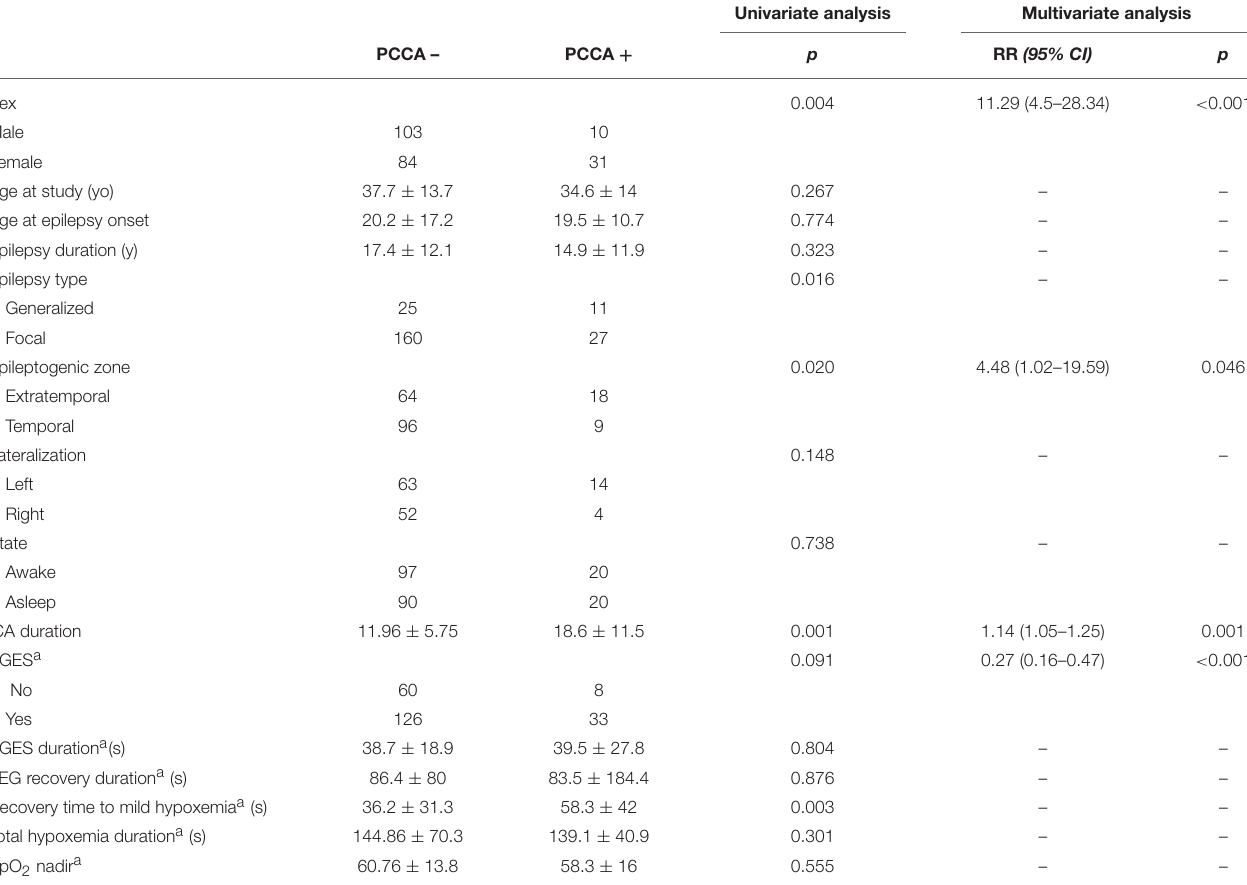
TABLE 3 | PCCA incidence and seizure